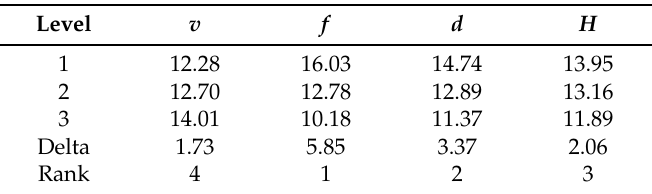
Table 10. Mean of S / N response for surface roughness.